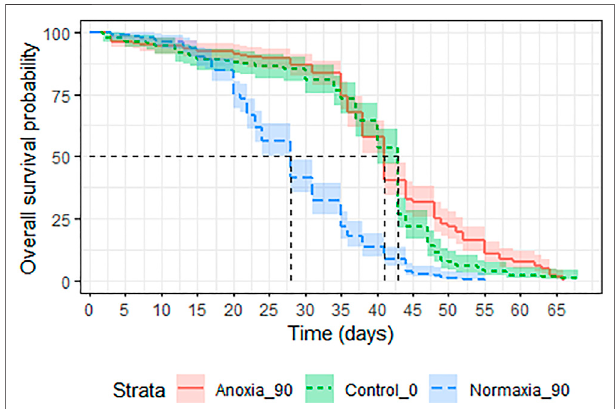
FIGURE 9 | Longevity of adult male Aedes albopictus irradiated at high dose (90 Gy) in normoxia (O 2 ) or anoxia (N 2 ) compared to untreated controls.